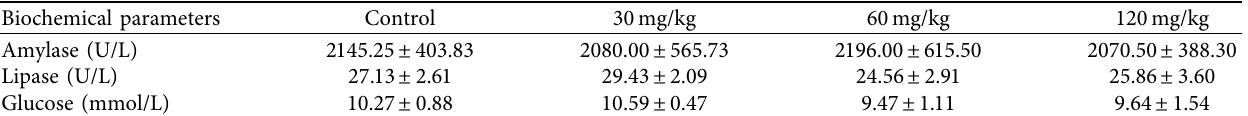
Table 7: The effects of goose bone on pancreatic